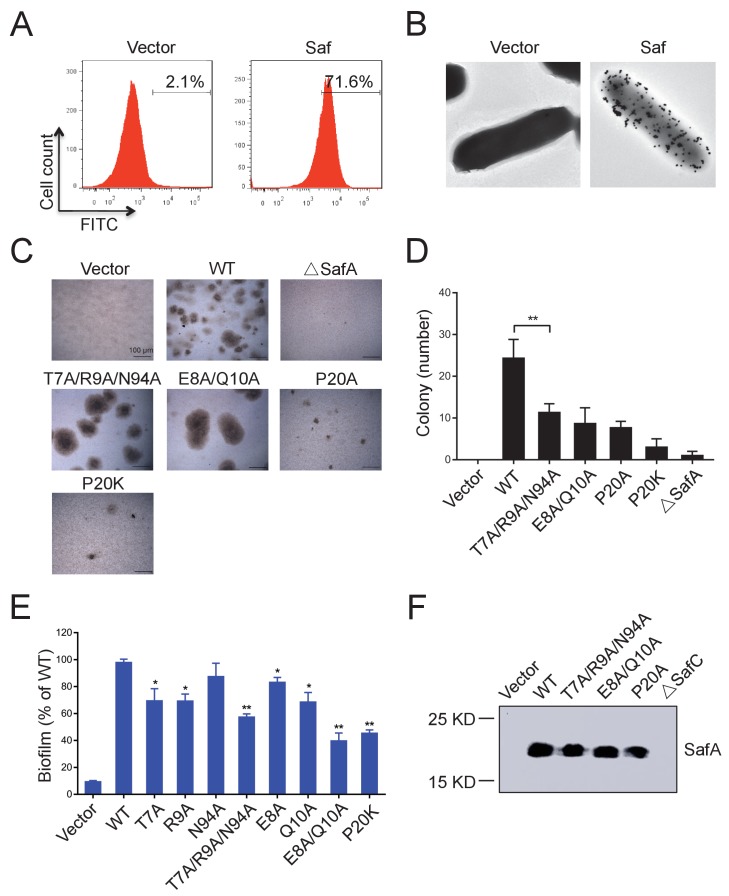
Inter-cellular SafDAA-SafDAA self-association drives biofilm formation.(A) The flow cytometry assay was used to monitor the expression and surfacing of Saf pili in LB medium. The quantified surfacing efficiency of cells harboring pASK-IBA4-Saf was 71.6%, in comparison to the background value of 2.1% for the empty pASK-IBA4 vector. (B) EM visualization of Saf surfacing using anti-strep immunogold. Top left: control cells that contained empty pASK-IBA4 vector. Top right, E.coli cells harboring pASK-IBA4-Saf. Both sets of the cells are incubated with anti-strep immunogod particles (black dots) prior to EM inspection. (C) Saf-driven cell aggregation visualized by light microscopy. After induction with 2% AHT for 24 hr in a 96-well plate, the colonization ability of WT Saf pili and muants were visualized by light microscopy. (D) Quantitative analysis of cell aggregation assay (C). The average number of colony formation for WT and mutants were calculated from three independent experiments in a 96-well plate. **p<0.01, statistically significant compared with WT. (E) Structure-based mutagenesis and biofilm formation assay. The wild-type (WT) Saf pili and the mutants that target the self-association were expressed in E.coli DH5α using pASK-IBA-Saf. The biofilm formation was quantified using crystal violet staining. For the purpose of comparison, the self-associating/biofilm-formation activities of mutants were normalized against WT and showed in percentage values. All experiments have been done at least with three independent replicates. Values are means ±S.E. from three independent experiments. *p<0.05 and **p<0.01 are used for statistic analysis between WT and mutants. (F) The expression levels of WT Saf pili and mutants in E.coli. The bacterial outer membrane (OM) fraction harboring WT Saf or mutants was extracted and subjected to western blot analysis using antibody against strep-SafA. The pASK-IBA4-SafABD, that is, ΔSafC, was used as negative control.10.7554/eLife.28619.020Figure 7—source data 1.Source data for Figure 7D.The average number of colony formation for WT Saf pili and mutants (three replicates).10.7554/eLife.28619.021Figure 7—source data 2.Source data for Figure 7E.The biofilm formation acitivties of Saf pili and mutant quantified by OD570 absorance values (three replicates). For the purpose of comparison, the self-associating/biofilm-formation activities of mutants were normalized against WT and showed in percentage values.